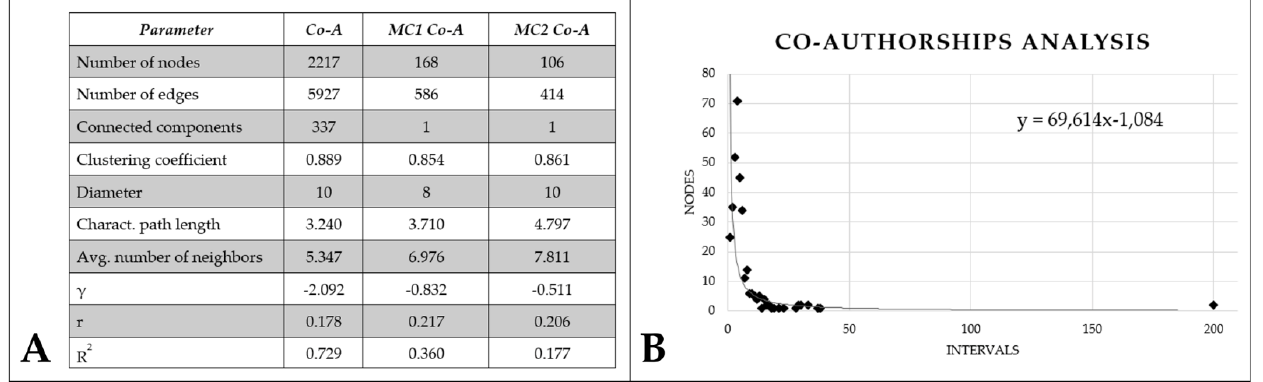
Figure 9. Topological analysis of the co-authorship network. Table ( A ) shows the numerical data extracted from the analysis, reaching a total of 2217 connections between the 337 authors. Co-A = Co-Authorship Network, MC1 Co-A and MC2 Co-A = Main-Component- Co-Authorship Network 1 and 2 are the two larger subnetworks of Co-A (i.e., the two main groups from Figure 8). Graph ( B ) represents the intervals in which the components (authors) were subdivided and the frequency of the nodes (connections) among them.